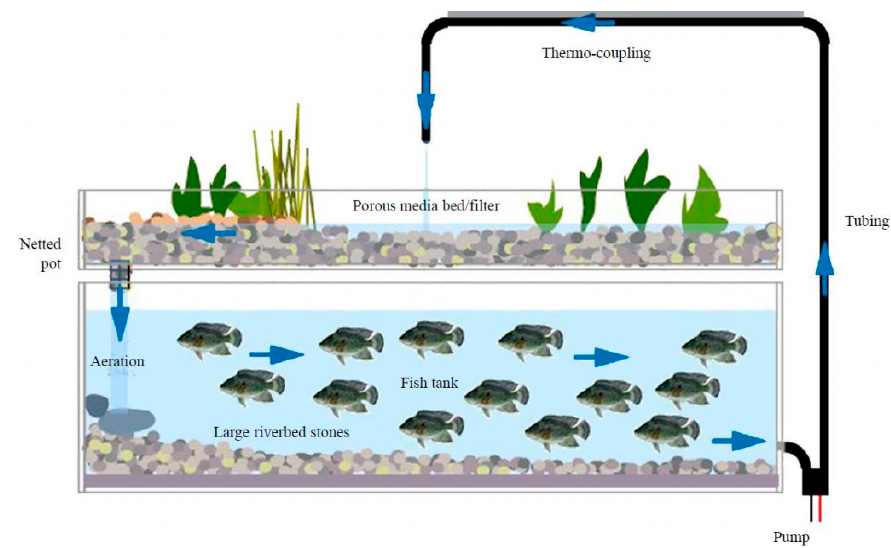
Figure 3. Schematic diagram of the aquaponics vertical farm. Reprinted from ref. [7].